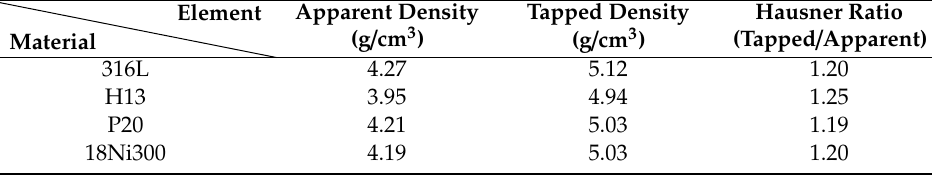
Table 2. The apparent density and tapped density of the four steels powders.